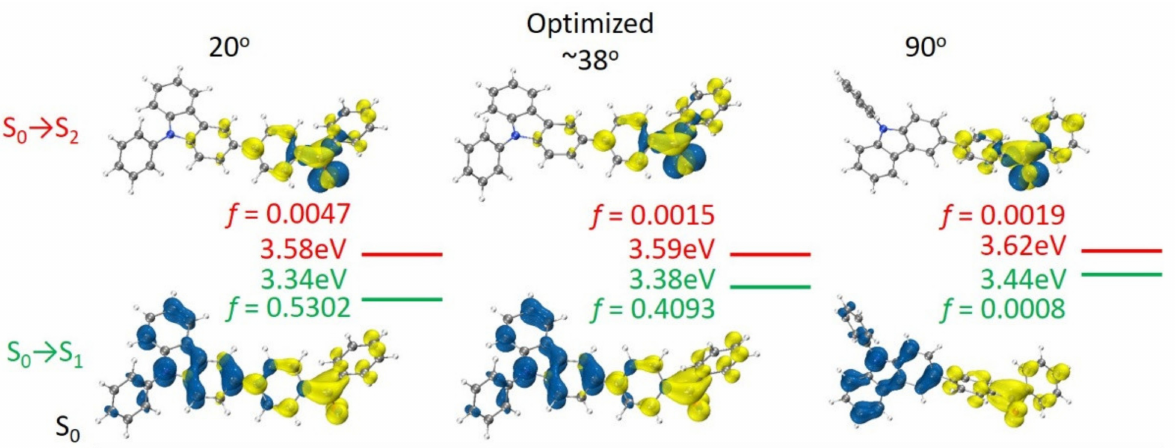
Figure 5. Natural transition orbitals of BP-3-Cz with different twist angles between the carbazole plane and benzophenone